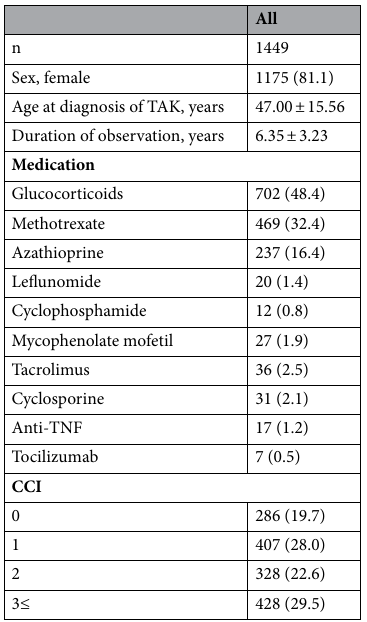
Table 1. Clinical characteristics of the study population. Numerical quantitative data are presented as mean ± standard deviation. Categorical data are presented as frequency (%). TAK , Takayasu’s arteritis; TNF , tumor necrosis factor; CCI, Charlson comorbidity